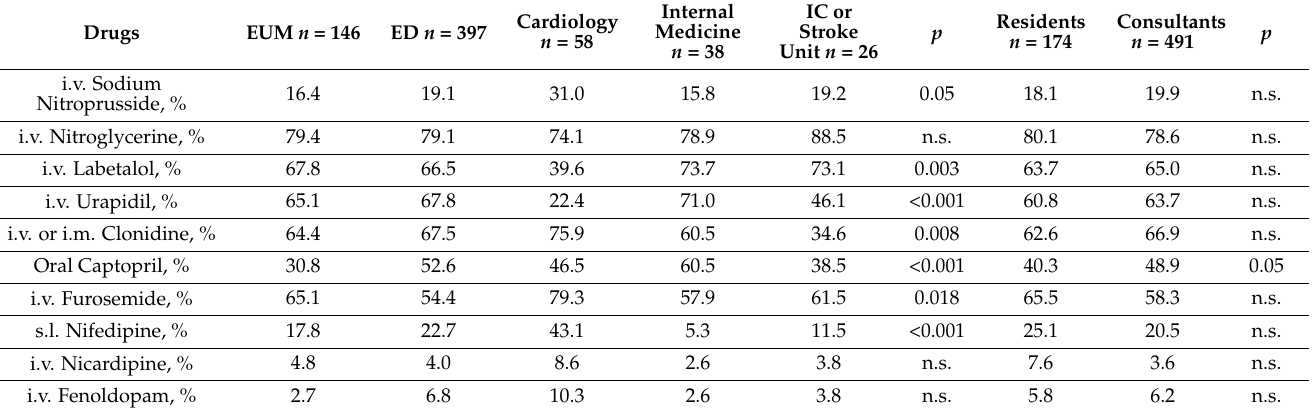
Table 6. Drugs administered to reduce an acute increase in BP, by department and qualification